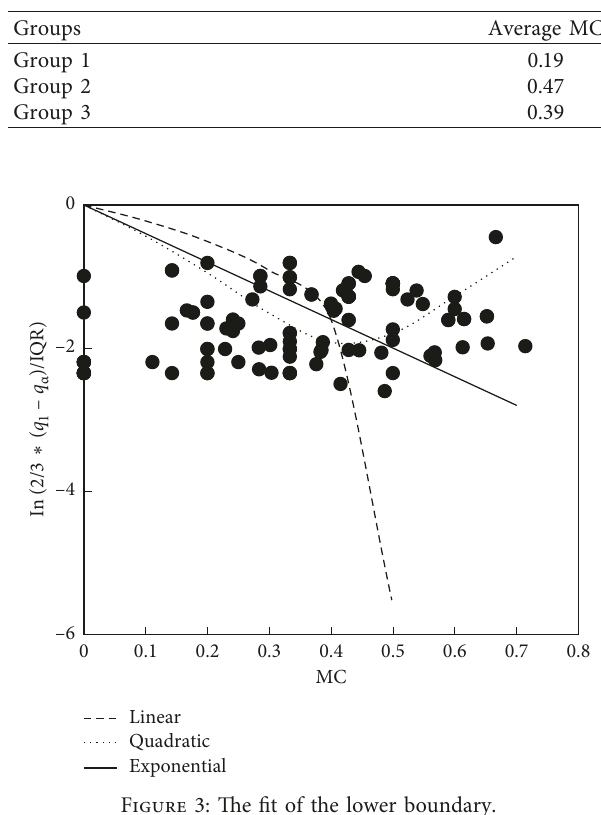
Table 1: Average MC values.